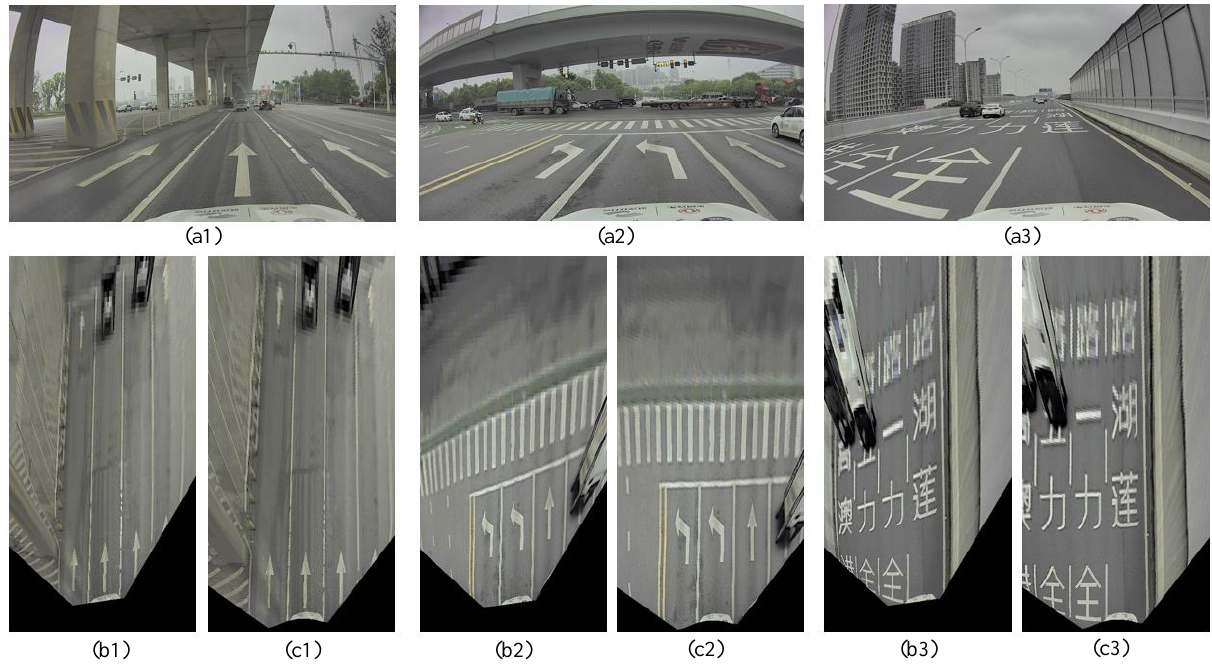
Figure 9 . BEV generated by different methods. (a) Perspective view. (b) BEV generated by the method proposed by Yang et al. (c) BEV generated by our